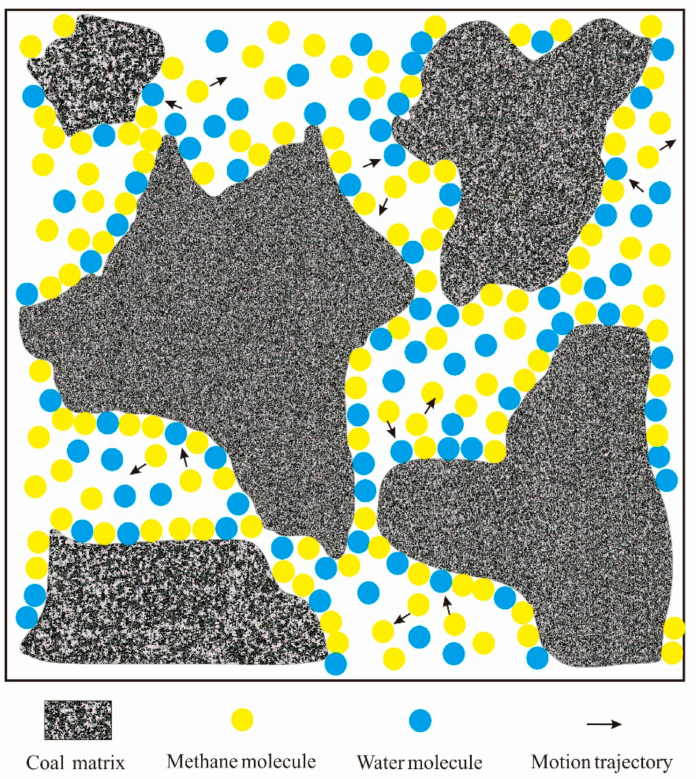
Figure 5. Competitive adsorption mode of methane and water